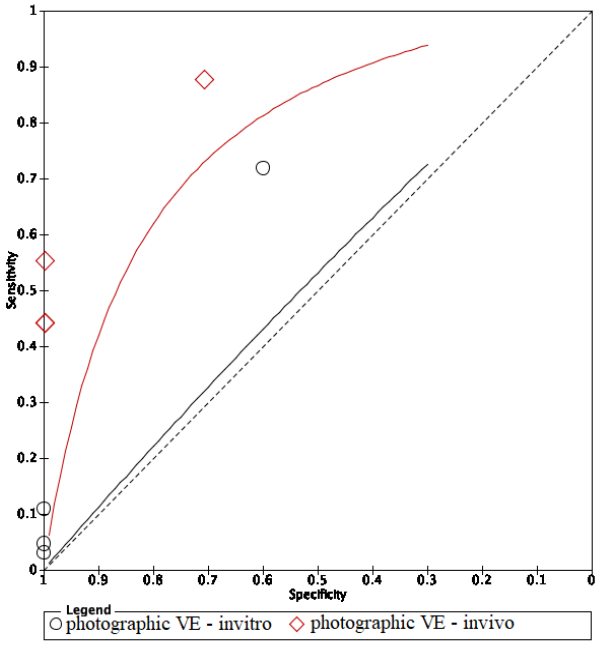
Figure 9. Comparison between in vitro and in vivo of visual photographic examination methods. The ROC curves of in vitro visual inspection and fluorescence coincided displaying the equivalence in both methods’ accuracy (Figures 10–12). The AUC of in vitro visual photographic examination was lower than that of in vitro fluorescence and visual detection.